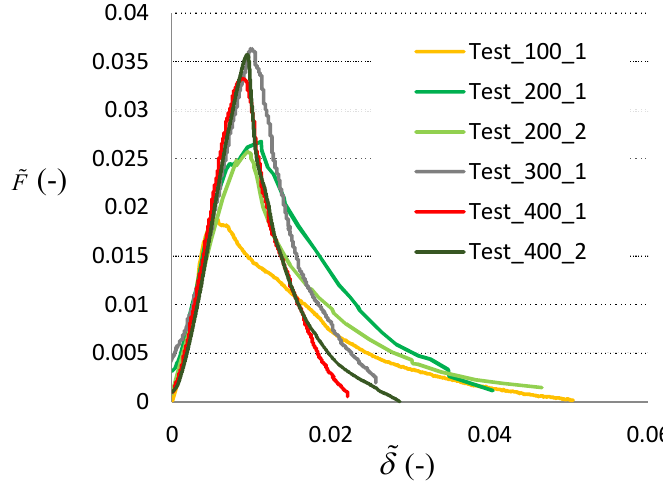
Figure 3. Renormalized load vs. deflection